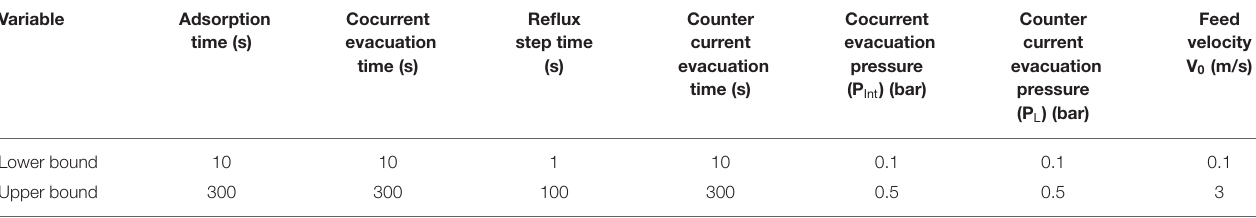
TABLE 1 | Upper and lower bounds for decision variables for the optimization of 6-step VSA process.